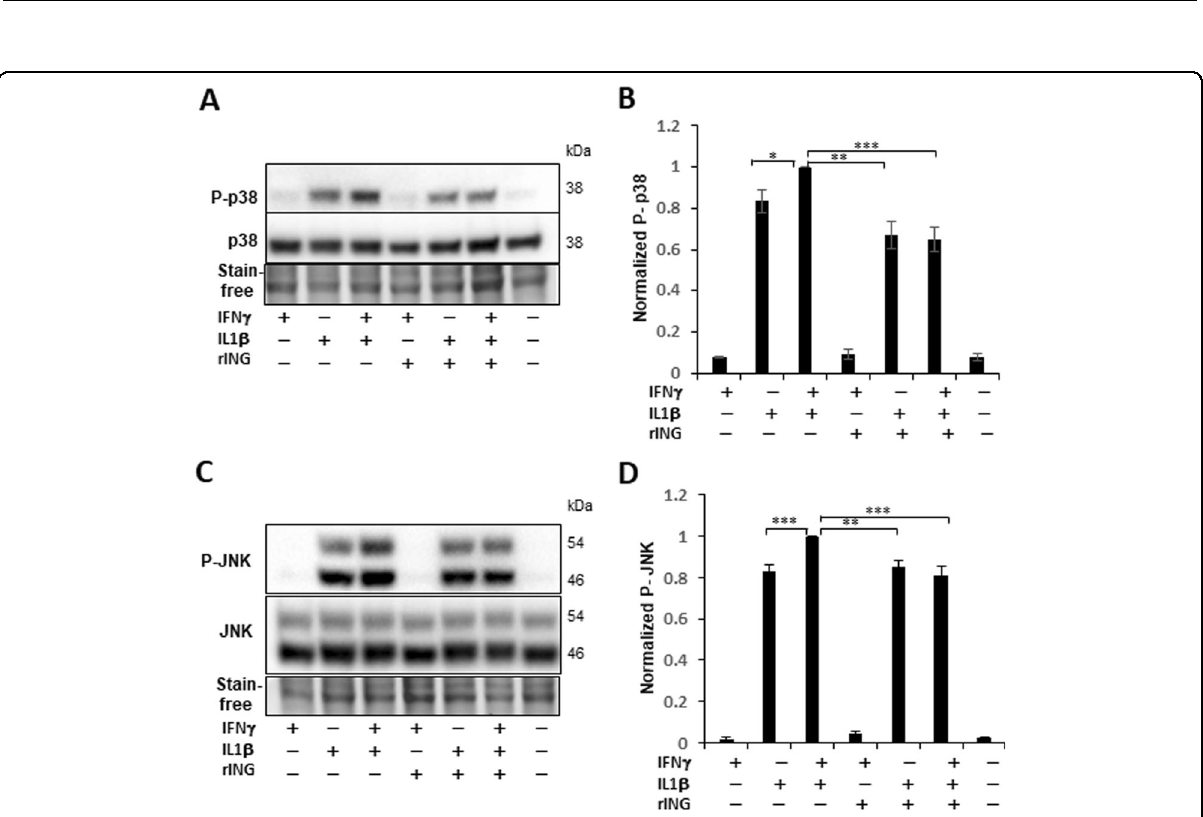
Fig. 7 rINGAP pre-treatment inhibits p38 and JNK activation when IL-1 β used with IFN γ but not alone. RINm5F cells were pre-treated with 1 nM rINGAP for 2 h and exposed to cytokines for 30 min. Lysates were resolved on stain-free SDS-PAGE and probed for: A , B P-(phospho)-p38 and C , D P-JNK followed by pan- p38 and JNK antibodies. A, C Shown are representative blots of eight experiments and B, D the results of densitometric analysis shown as a ratio of phospho/total protein relative to the cytokine cocktail. * P < 0.05, ** p < 0.005, *** p < 0.001 ( t